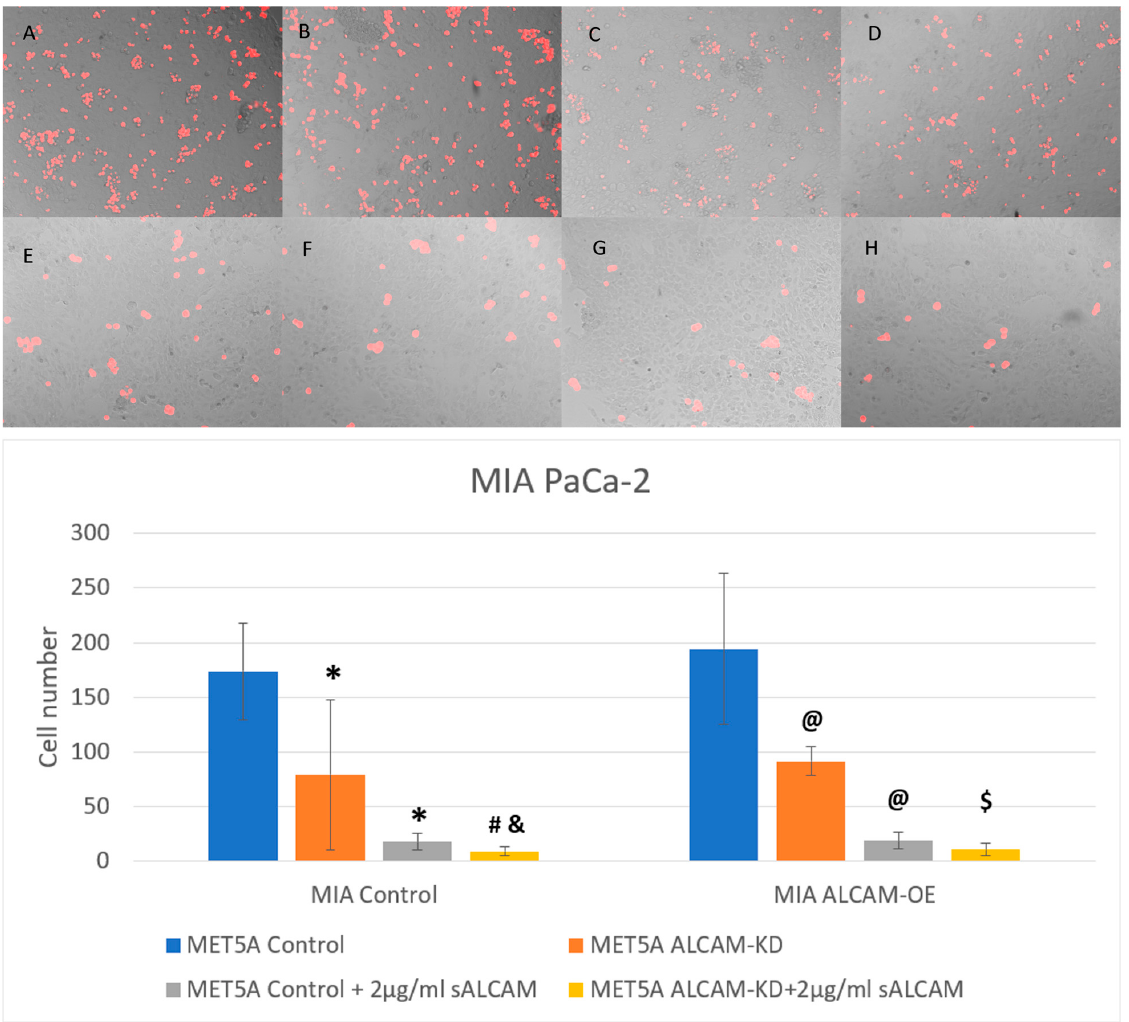
Figure 8. Interaction between pancreatic cancer cell line MIA PaCa-2 and mesothelial cell line MET5A as determined by the DiI based assays. ( Top ): Representative images (×10 magnification) of pancreatic cancer cells (MIA PaCa-2 Control and ALCAM overexpression cells) adherence to mes- othelial cells (MET5A Control and ALCAM knockdown cells). ( A – D ) represent wells without